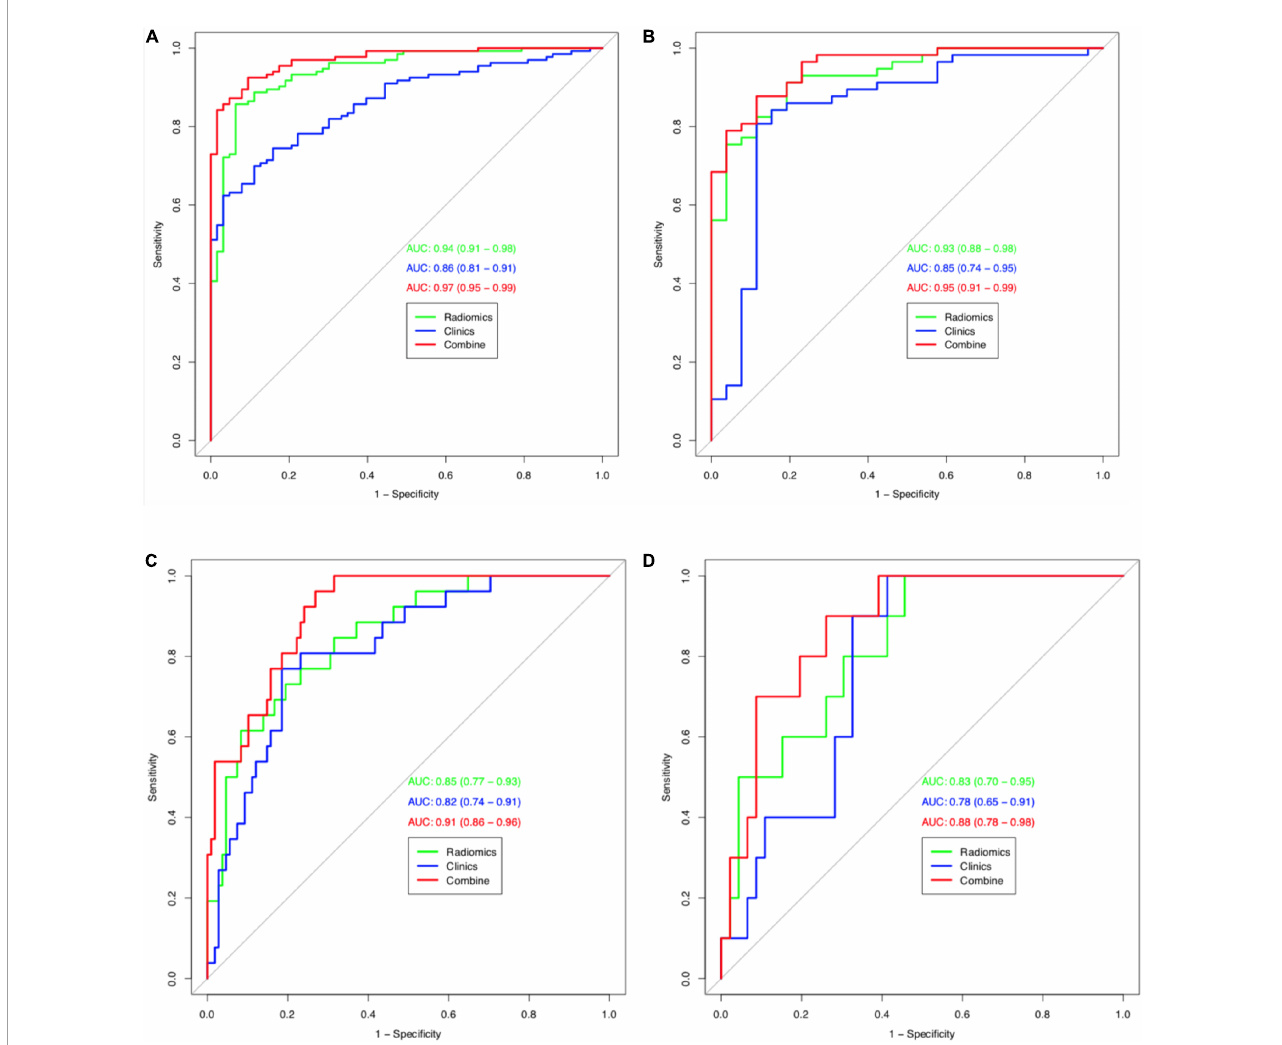
FIGURE3 Receiver operating characteristic (ROC) curves (HIE vs. normal) for training cohort (A) and validation cohort (B) for tree models. Receiver operating characteristic (ROC) curves (good outcome vs. poor outcome) for training cohort (C) and validation cohort (D) for tree models.